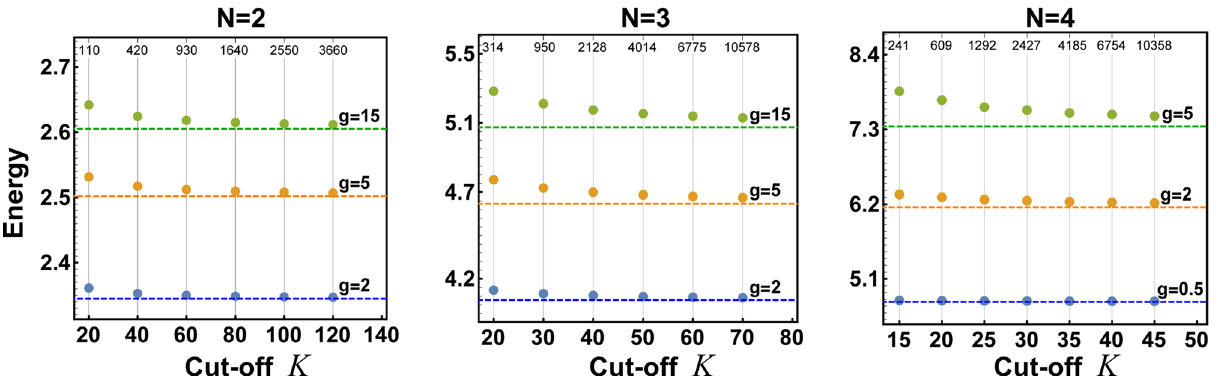
2, 3 , and 4 particles as predicted by the ansatz (horizontal Figure 5. Ground-state energy of the system of N = dashed lines) and as obtained by the numerically exact diagonalization of the Hamiltonian (1) in the cropped Fock basis with cut-off K . Labels on thin vertical lines denote sizes of corresponding cropped Hilbert spaces. Note that along with increasing cut-off K the numerically exact results converge from above to the ansatz’s predictions. This indicates that the variational scheme proposed, although relatively simple and numerically less demanding, typically gives very accurate and better results than very heavy calculations in the framework of the matrix diagonalization. In the presented examples, calculations are performed for the same trap as in Fig. 4 (corresponding to the second column in Fig.